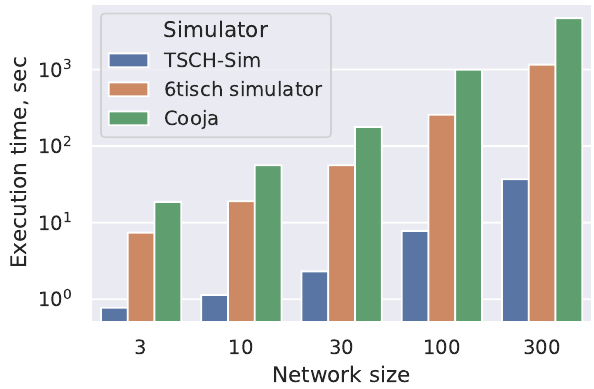
Figure 9. Simulation execution time depending on network size, 1h simulations in random networks.